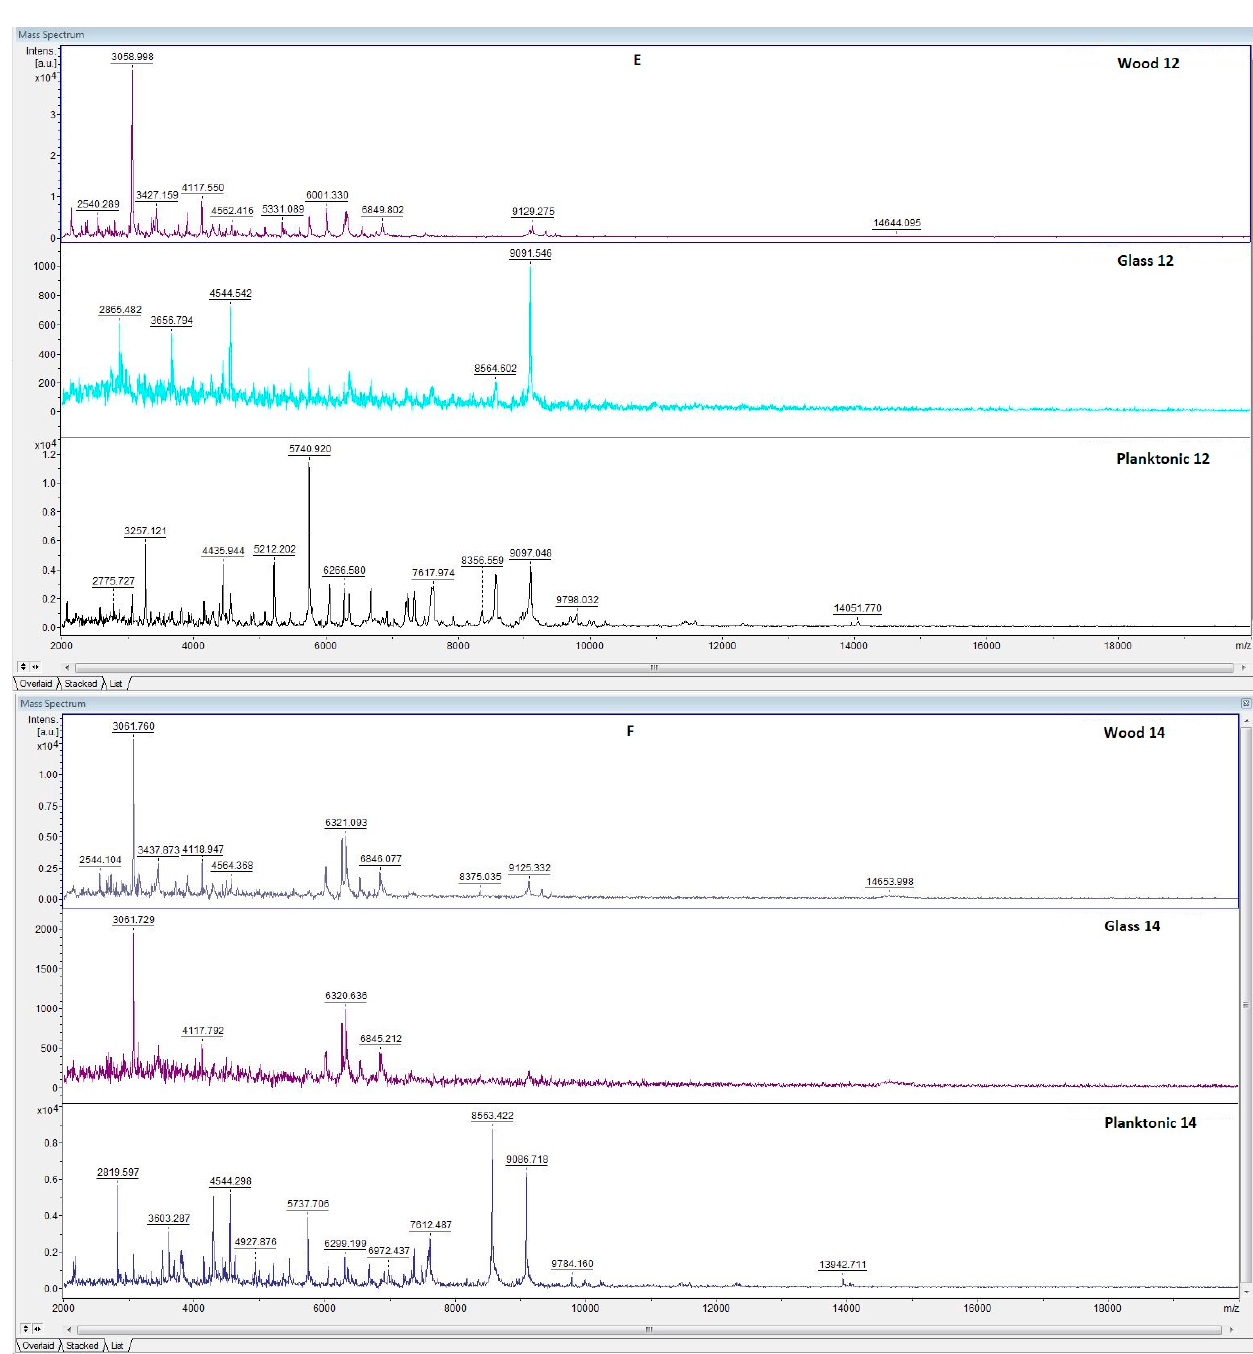
Figure 1. MALDI-TOF mass spectra of the biofilm produced by LGEO-treated P. fluorescens during development: ( A ) 3rd day, ( B ) 5th day, ( C ) 7th day, ( D ) 9th day, ( E ) 12th day and ( F ) 14th day. PF: P. fluorescens ; C: control; G: glass; W: wood and P: planktonic.